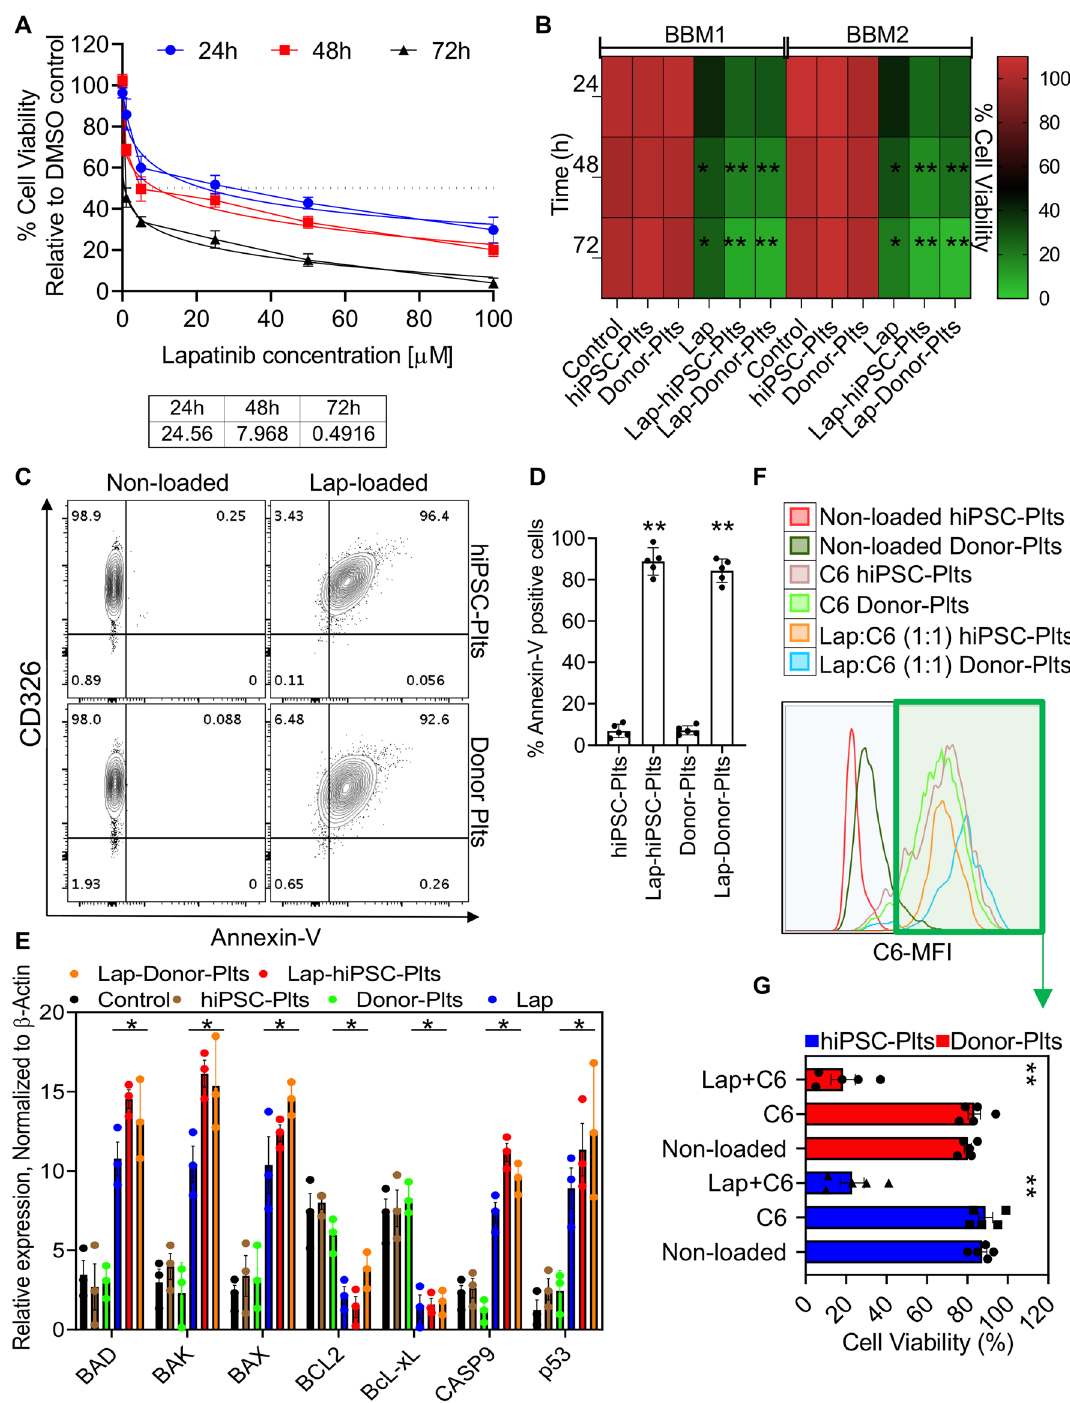
Figure 3. Toxicity studies in BBM cells. (A) The effect of lapatinib-loaded hiPSC-platelets against BBM cells at 24, 48, and 72 h, with various concentrations of lapatinib loaded into the hiPSC-platelets. The inset table (bottom) shows the IC 50 (µM) of lapatinib-loaded hiPSC-platelets against BBM cells at 24, 48, and 72 h (mean ± SD, n = 3). (B) Cytotoxic effects of non-loaded hiPSC- and donor-derived platelets, free lapatinib, and lapatinib-loaded hiPSC- and donor- derived platelets on BBM1 and BBM2 cells at 24, 48, and 72 h. ** indicates p < 0.001. (C) Representative flow cytometry plots demonstrating the surface expression of Annexin-V on CD326 + BBM cells exposed to non-loaded and lapatinib- loaded hiPSC- and donor-derived platelets. (D) Surface Annexin-V quantification of BBM cells exposed to non- loaded and lapatinib-loaded hiPSC- and donor-derived platelets (mean ± SD, n = 3). ** indicates p < 0.001. (E) mRNA expression of apoptosis-associated genes in BBM cells under various treatment conditions, evaluated by TaqMan RT-qPCR. * indicates p < 0.001. (F) Representative flow cytometry plot showing BBM cells exposed to non-loaded, C6-loaded, and 1:1 lapatinib + C6-loaded hiPSC- and donor-derived platelets for 48 h. (G) CCK8 viability assay results showing the percentage of viable BBM cells after exposure to non-loaded, C6-loaded, and 1:1 lapatinib + C6-loaded hiPSC- and donor-derived platelets for 48 h (mean ± SD, n = 3). ** indicates p <